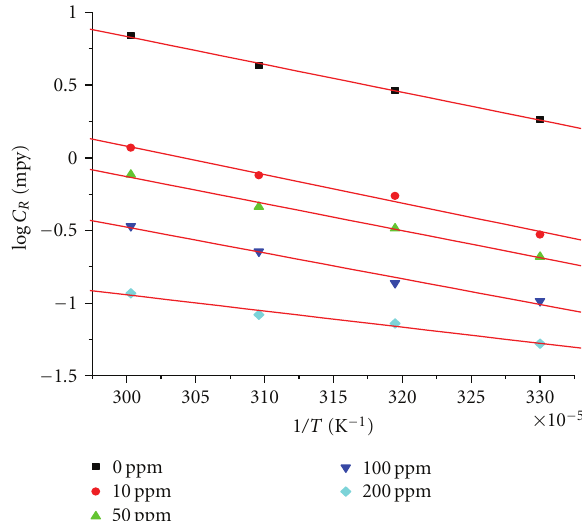
Figure 5: Arrhenius plot for mild steel in 1 M HCl solution in the absence and presence of di ff erent concentrations of the